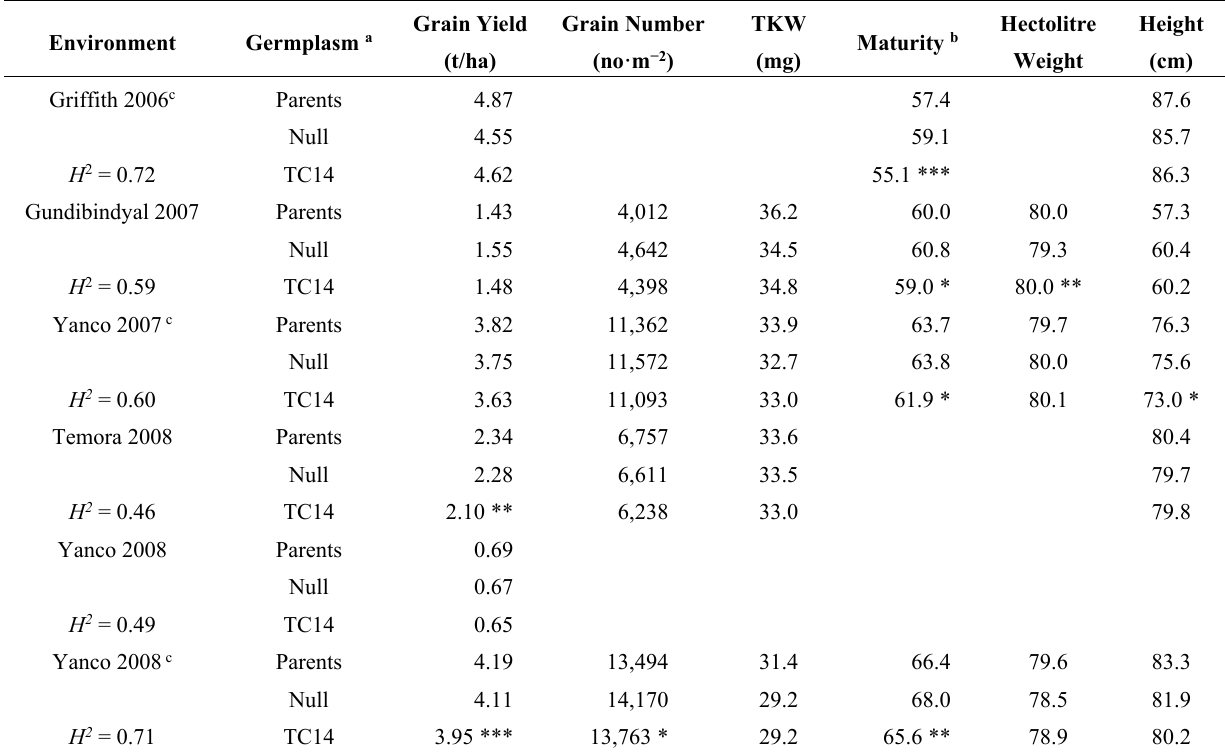
Table 4. Effects of the TC14 ( Bdv2 ) translocation on yield, yield components, maturity and height.